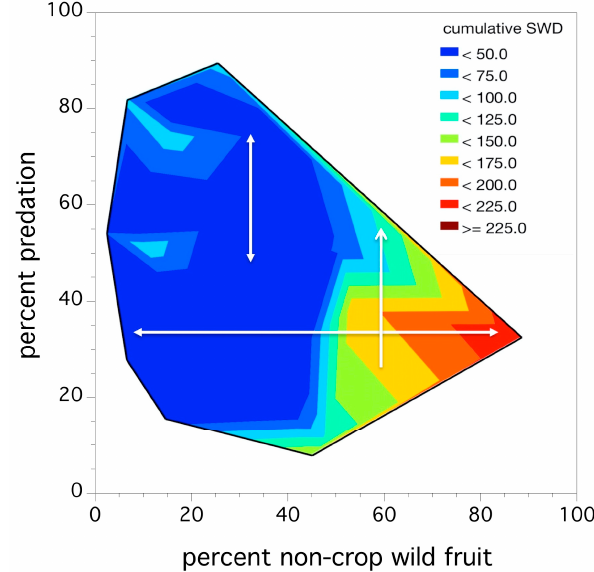
Figure 8. Thermograph of cumulative seasonal relative abundance of D. suzukii captures mean flies / trap in fruit-bearing fields as a function of pupal predation (x-axis) and non-crop wild fruit hosts (y-axis). Colors denote D. suzukii relative abundance, darker blue regions are low and red regions are high adult relative abundances. White arrows show the change in adult relative abundance as percent predation and percent non-crop wild fruit changes.